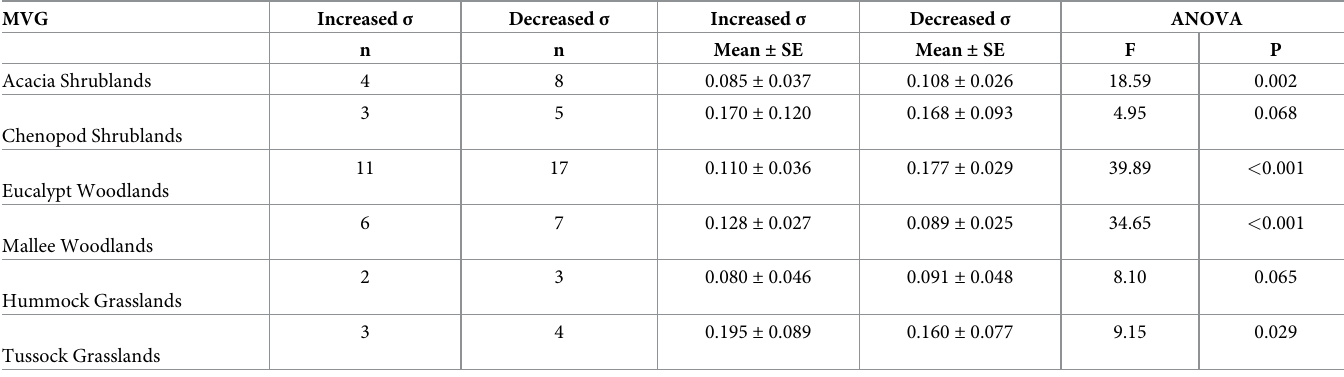
Table 1. Log-normal sigma for rank-dominance curves. MVG